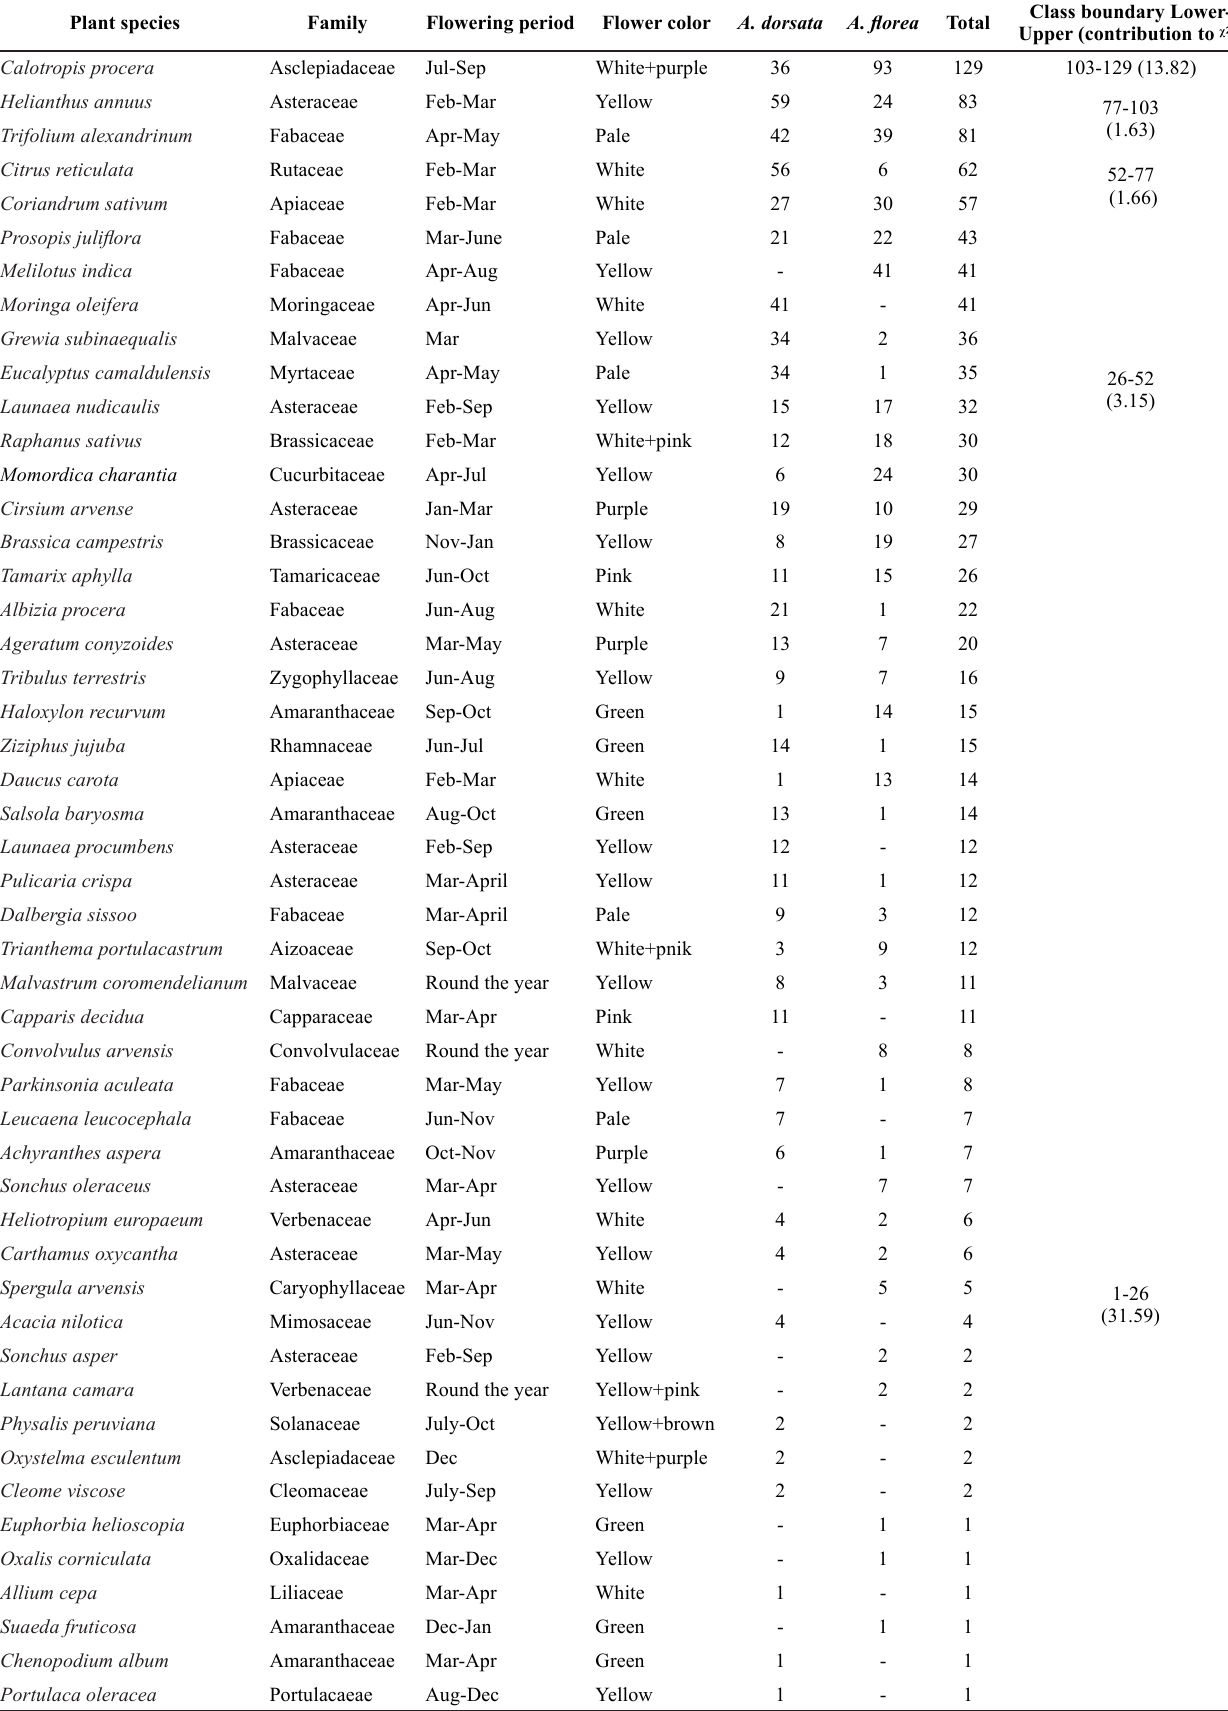
Table 1 . Monthly abundance of bees, on 49 plant species at Bahauddin Zakariya University Campus, Multan Pakistan during January to December, 2008. Plant